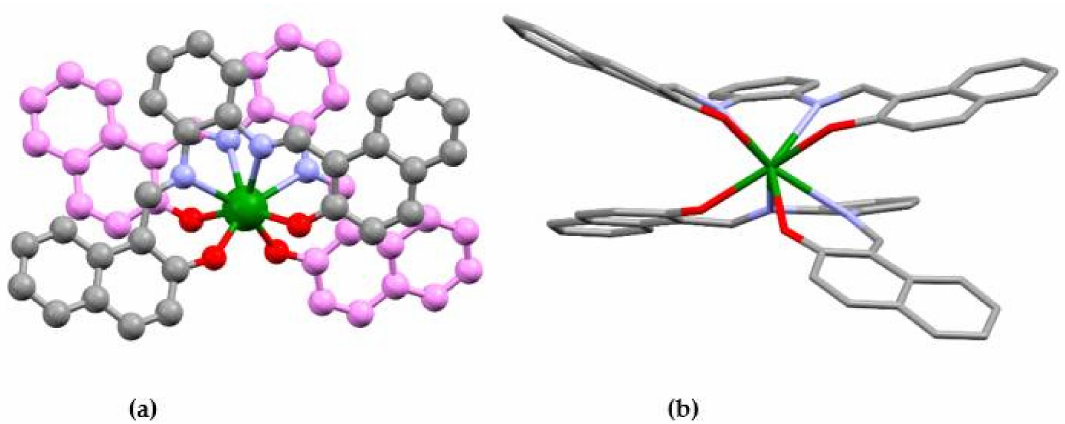
Figure 3. ( a ) Crystal structure of SYML1-Ce. One ligand is shown in light purple and hydrogens are not shown for clarity, top view. ( b ) Side view of SYML1-Ce. Carbon: gray. Oxygen: red. Nitrogen: blue. Cerium: green.